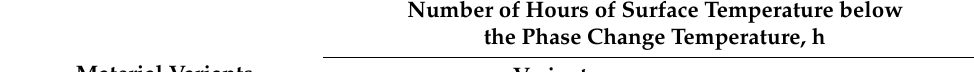
Figure 9. Average hourly values of radiation temperature of partitions inside a building with